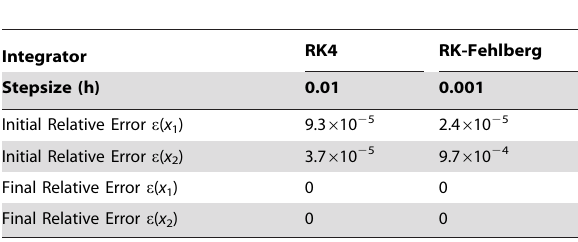
Table 1. Development of relative error of LCM period for different